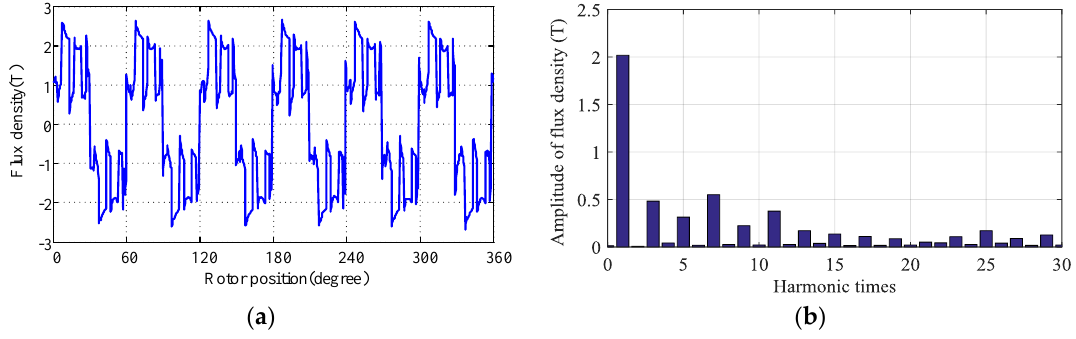
Figure 10. The air-gap flux density waveform ( a ) of the CPM and its harmonic analysis ( b ).